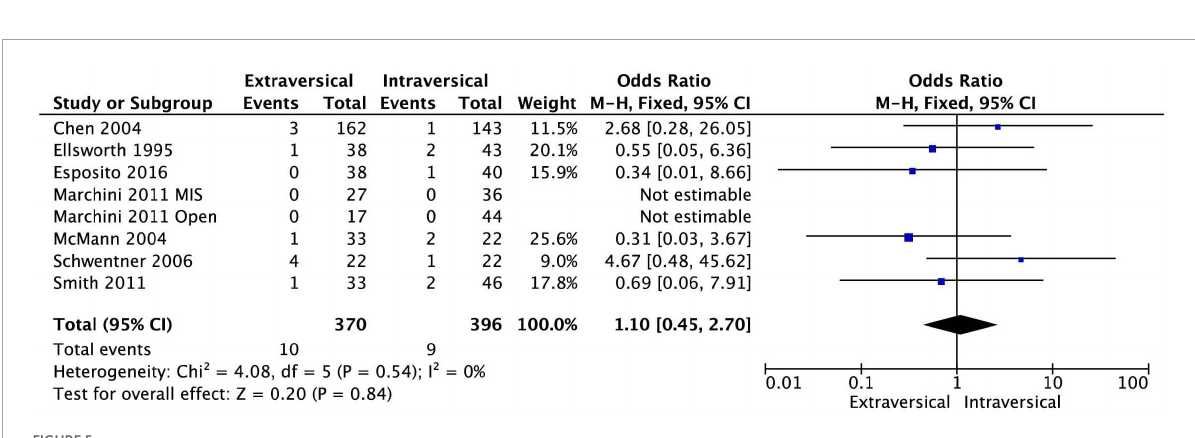
FIGURE5 Forest plot of postoperative hydronephrosis after EVUR vs. IVUR for primary VUR